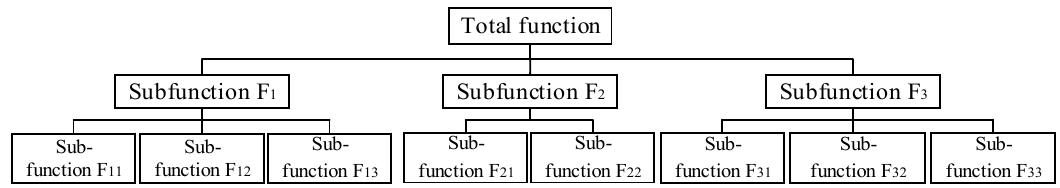
Figure 5. Functional decomposition process.